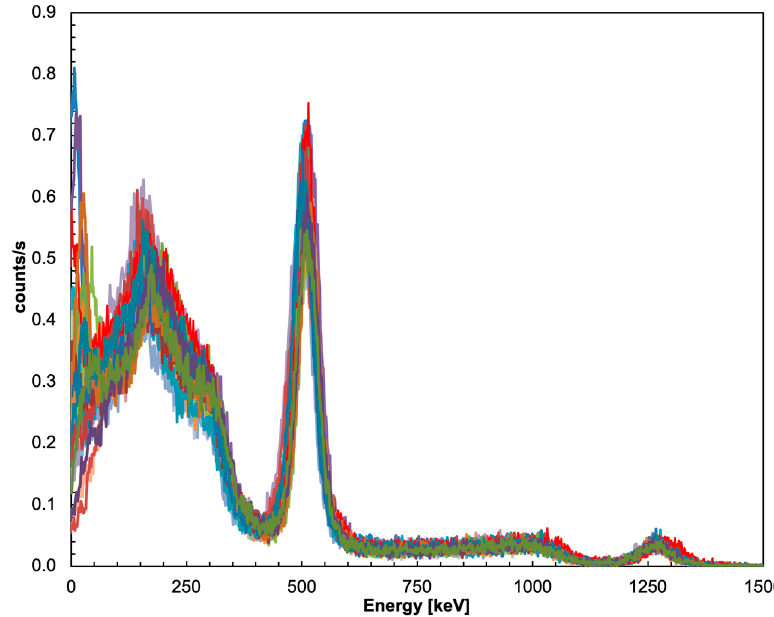
Figure 8. The 25 calibrated spectra from the configuration without the collimator.